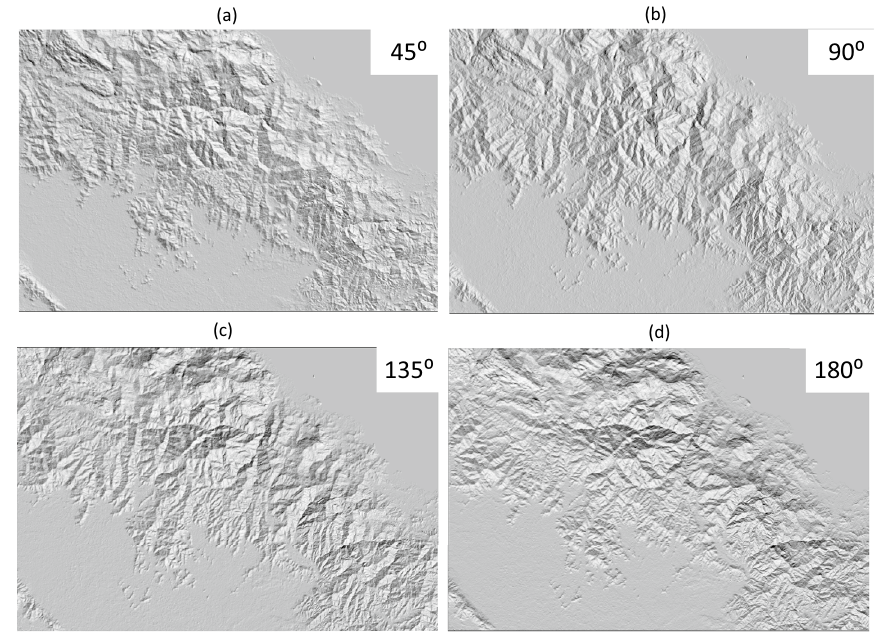
Fig. 6 Hill shade of study area from different angles of sun azimuth: a 45° sun azimuth, b 90° sun azimuth, c 135° sun azimuth, d 180° sun